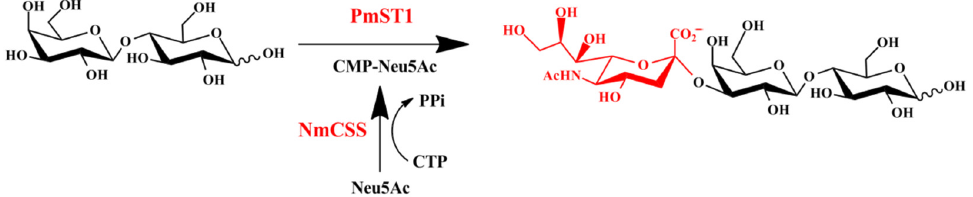
Figure 1. Analysis of α 2,3-sialyltransferase ( A ) and α 2,3-sialidase ( B ) activities of M144D by TLC. Lane 1, Lac; Lane 2, 0 h; Lane 3, 2 h; Lane 4, 6 h; Lane 5, 10 h; Lane 6, 24 h; Lane 7, 48 h; Lane 8, 72 h; Lane 9, 96 h; Lane 10, 120 h; Lane 11, S’-SL.